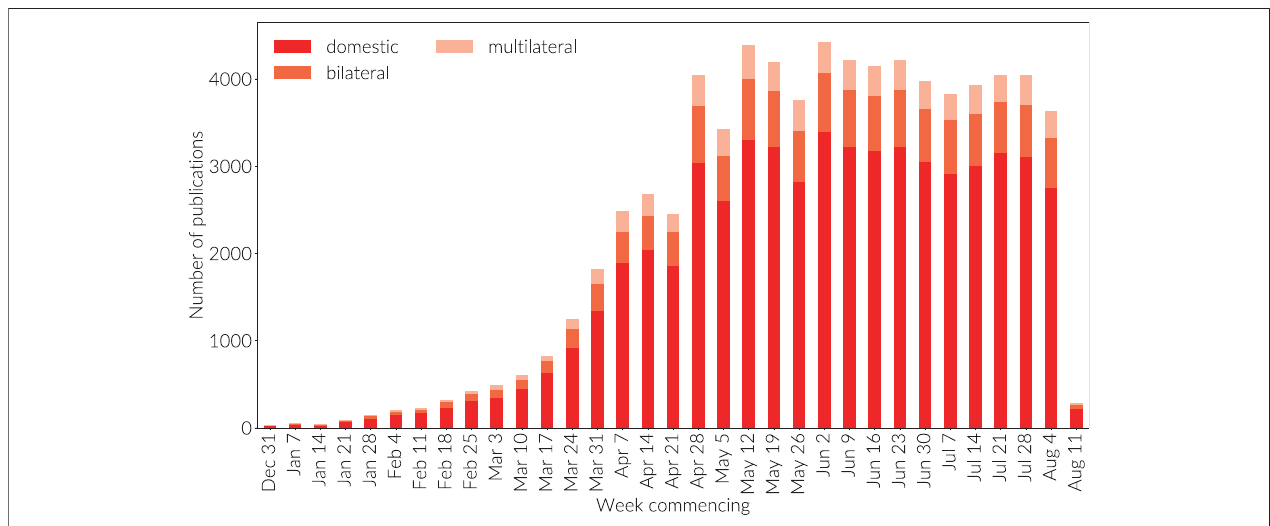
FIGURE8| Countofdomestic,bilateral,andmultilateralcountrycollaborations.Thisgraphisnotcumulative.Papersaregroupedbytheweekcommencingonthe dates given; the fi nal week is incomplete.